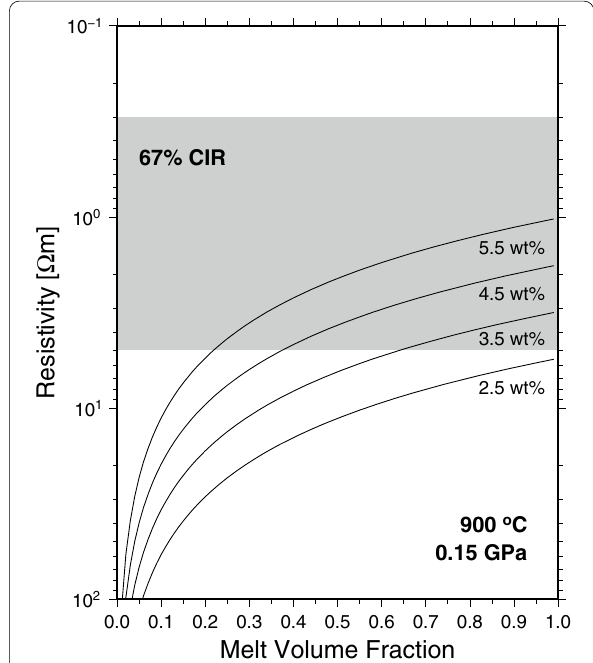
Fig. 19 Bulk resistivity (solid line) of dacitic melt and rock complex at 900 °C, 0.15 GPa as a function of melt volume fraction and of water content in the dacitic melt. The gray shaded area represents the 67% CIR of Fig. 14b, and the solid lines show water content of dacitic melt in weight percent. Note that the upper and lower bound of 67% CIR is the bottom and top of the gray shaded area, respectively. Melt resistivity is calculated from Laumonier et al. (2015). Solid phase resistivity is fixed at 1000 Ωm [e.g., granite data of Kariya and Shankland